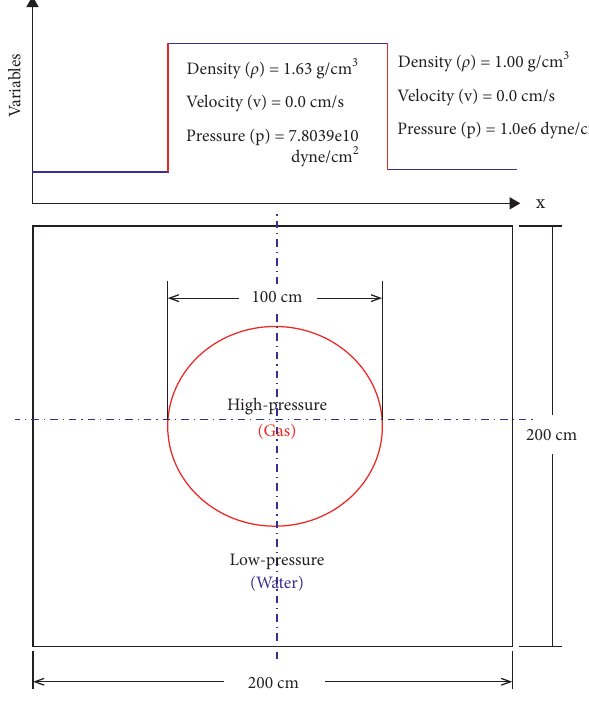
Figure 9: Initial conditions of Case